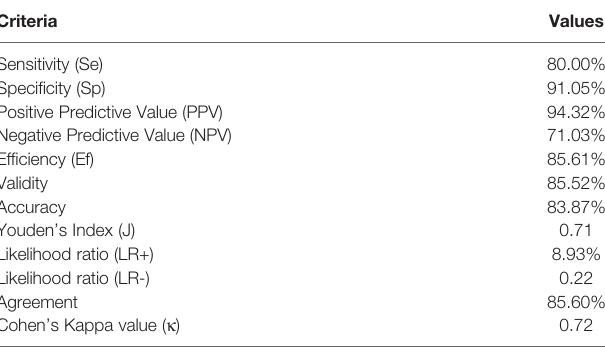
TABLE 1 | Indirect ELISA diagnostic performance criteria. Criteria Values Sensitivity